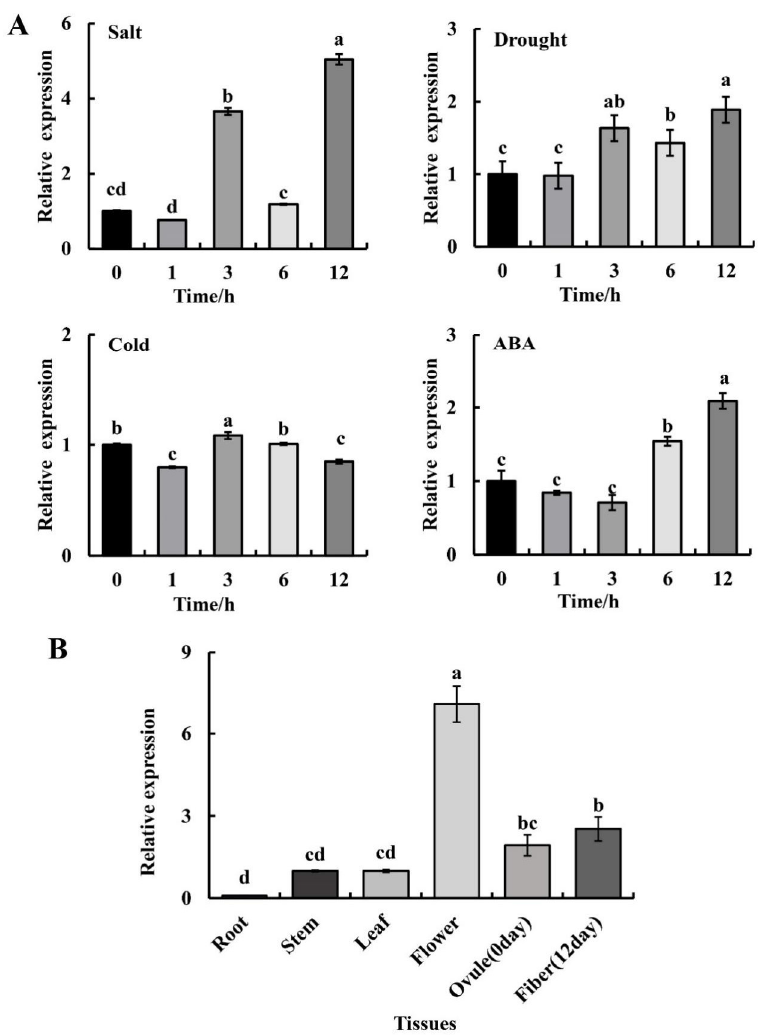
Figure 2. Relative expression of GhGT26 in response to different stress factors and in different tissues as revealed by qRT-PCR. ( A ) Expression of GhGT26 transcript abundance in cotton leaves after NaCl, drought, cold, and ABA treatments. Actin was used for normalization. ( B ) Gene expressions in different organs of cotton plants were analyzed. DPA, day post anthesis. The expression of the gene in the stem (untreated samples) was used as the control. Vertical bars indicate ±SD of three technical replicates of the pooled treated samples. The different letters above the columns indicate significant differences ( p < 0.05) based the EM-based Student t test performed using GraphPad Prism 8.0.